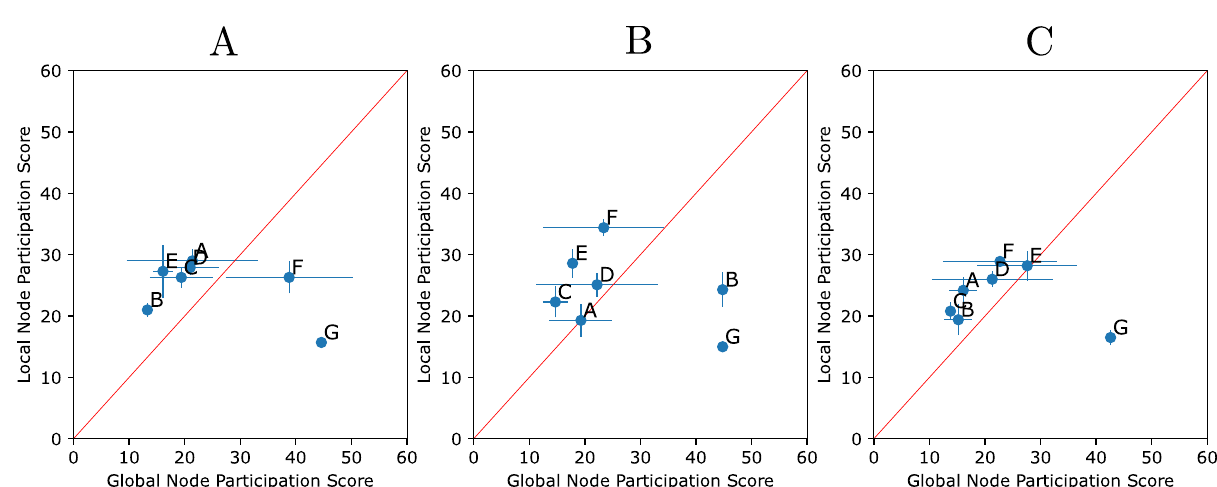
Fig 5. Local versus global node participation scores. Mean ± standard deviation node participation scores for the simulations shown in Fig 3B (panel A); Fig 3C (panel B); Fig 3D (panel C). Each synthetic dataset was run through the edge and network finding steps five times. The mean (blue dots) and standard deviation (blue bars) of the local node participation scores across the five runs is plotted against the mean and standard deviation of the global node participation scores. The node participation score for each simulation is computed only over the edges in the intersection of the top-ranked LEM edges of all five simulations. This excludes edges that do not have sufficiently high local edge ranks in all five simulations. Nodes located above the red diagonal line indicate an improved global node participation score versus their local node participation score. Notice that the node G is noticeably downranked in all three